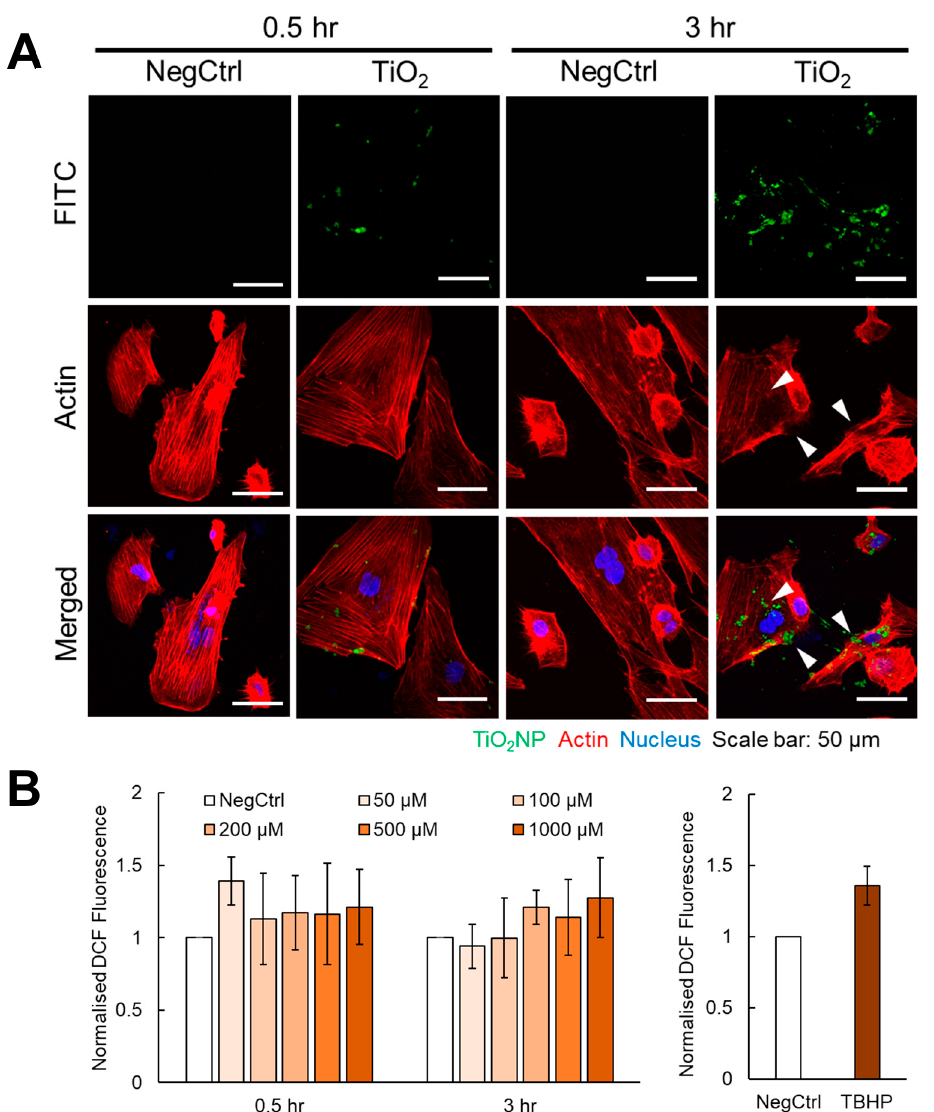
Figure 3. Internalised TiO 2 NPs did not significantly induce oxidative stress in HHSECs. ( A ) TiO 2 NPs conjugated with FITC (green) were internalised into HHSECs at two different timepoints of 0.5 and 3 h. White arrows indicate possible disruption of actin fibres. Actin was stained with phalloidin dye (red) and nucleus was stained with Hoechst dye (blue). Scale bar = 50 µ m. ( B ) H 2 DCF-DA assay revealed no significant increase in oxidative stress exhibited by HHSECs treated with varying concentrations of TiO 2 NPs at both timepoints. Tert-Butyl hydroperoxide (TBHP) was used as a positive control. Data represent mean ± SE ( n = 3).